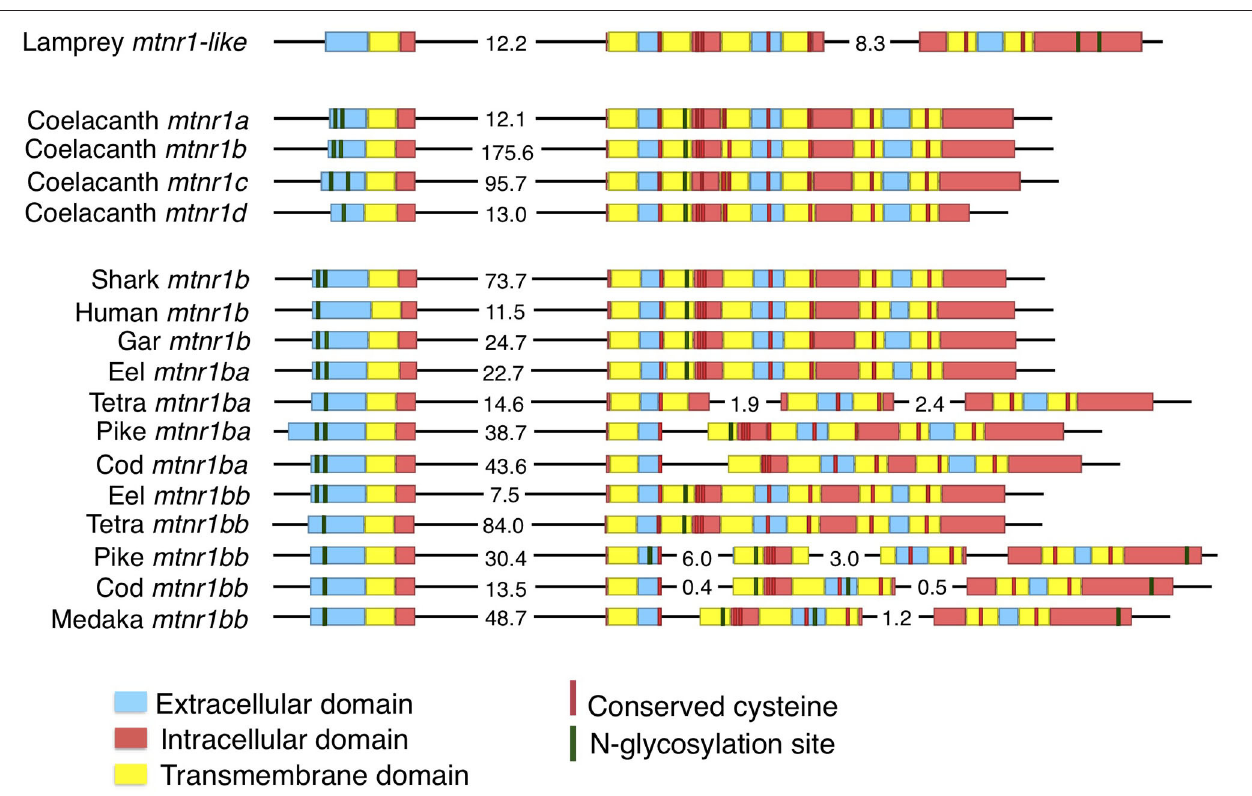
FIGURE 1 | Evolution of the gene structure of mtnr in vertebrates . Representation of the gene structure of the lamprey mtnr1-like, the four gnathostome mtnr subtypes represented by the four coelacanth mtnr , and gene of mtnr1b duplicates in teleosts. The gene representation includes the coding sequence and its features. Genomic DNA in 5 ′ -3 ′ orientation is represented by black lines, and the coding sequences with boxes. To save place, long intronic sequences have been cut and length is indicated in kb on the corresponding intron sequence. Within the coding sequences, the different domains of mtnr1b are represented by different colors; blue represents extracellular domains and loops, yellow for the transmembrane domain, and red for the intracellular loops and cytosolic tail. Predicted N-glycosylation sites are indicated in green, and conserved cysteine residues in red. Gene references are given in the Supplementary Table 1